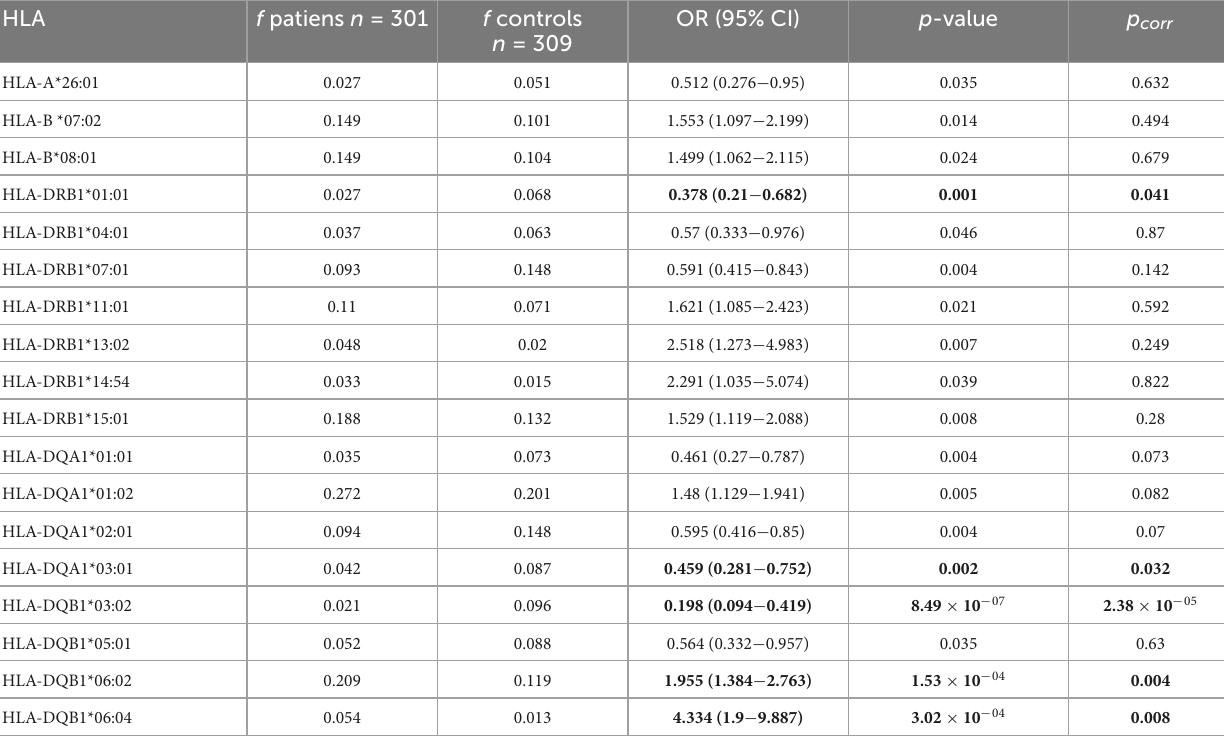
TABLE 2 Summary of the observed associations between HLA alleles and sarcoidosis in the investigated Czech patients (only the alleles associated at least on primary level are shown). f patiens n = 301 f controls OR (95% n = 309